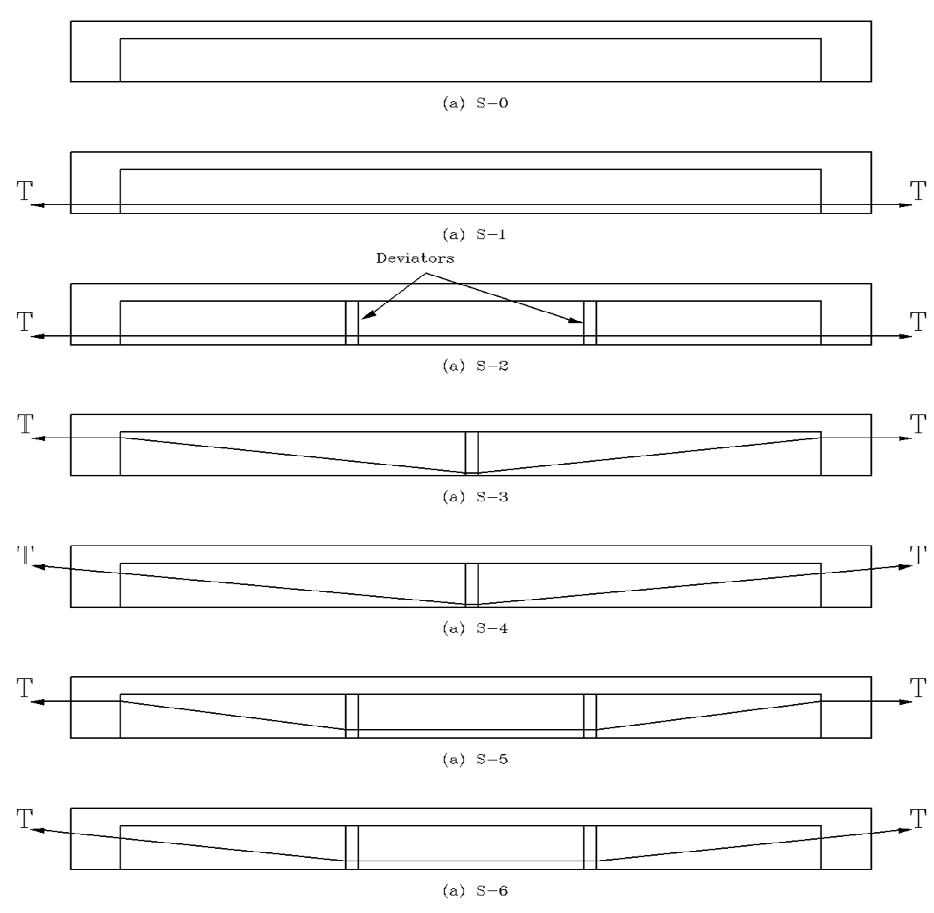
Figure 2. Several techniques for the external pre-stressing of simple beams.